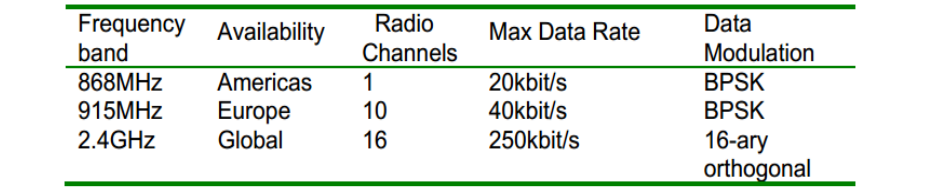
Table 2. ZigBee frequency band and their characteristics